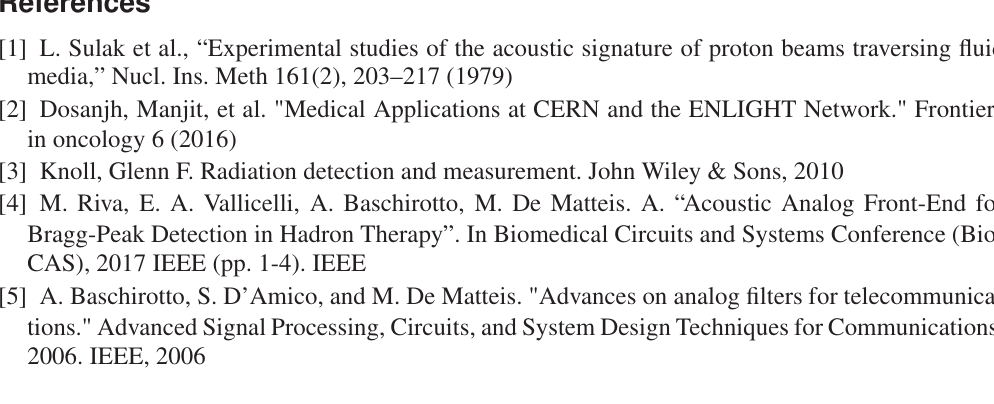
Figure 3. Left: AFE signals vs time. Right: Time of Flight and distance error histograms